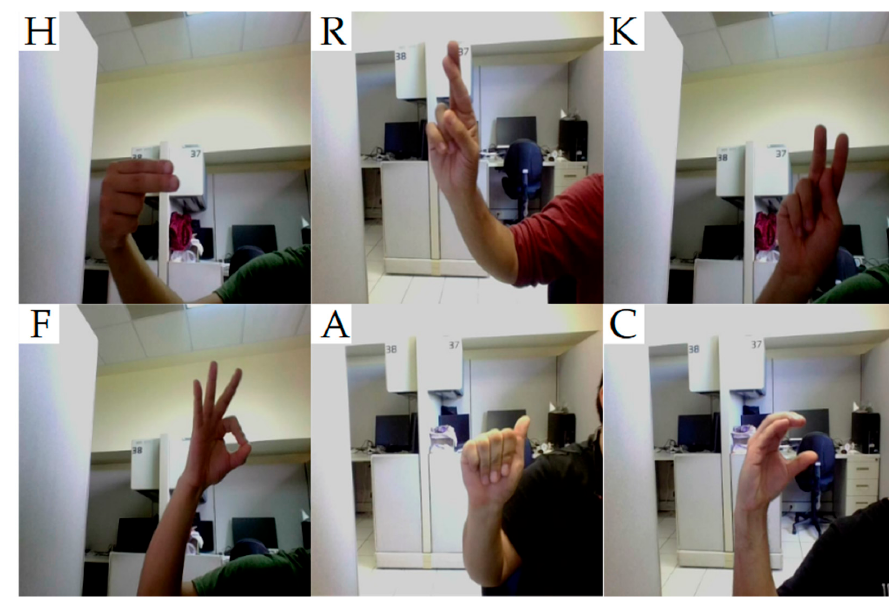
Figure 6. Samples of the signs H, R, K, F, A, and C of the ASLYset. Presented experimental results were obtained using a dataset generated for this spe-